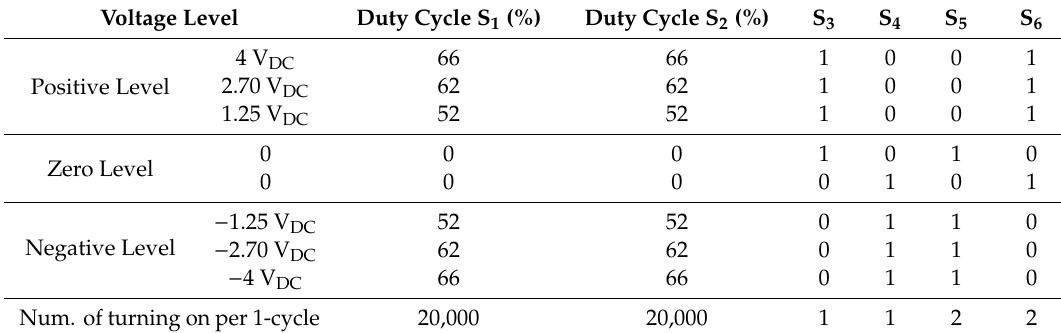
Table 8. Switching table level = 7, gain = 4.